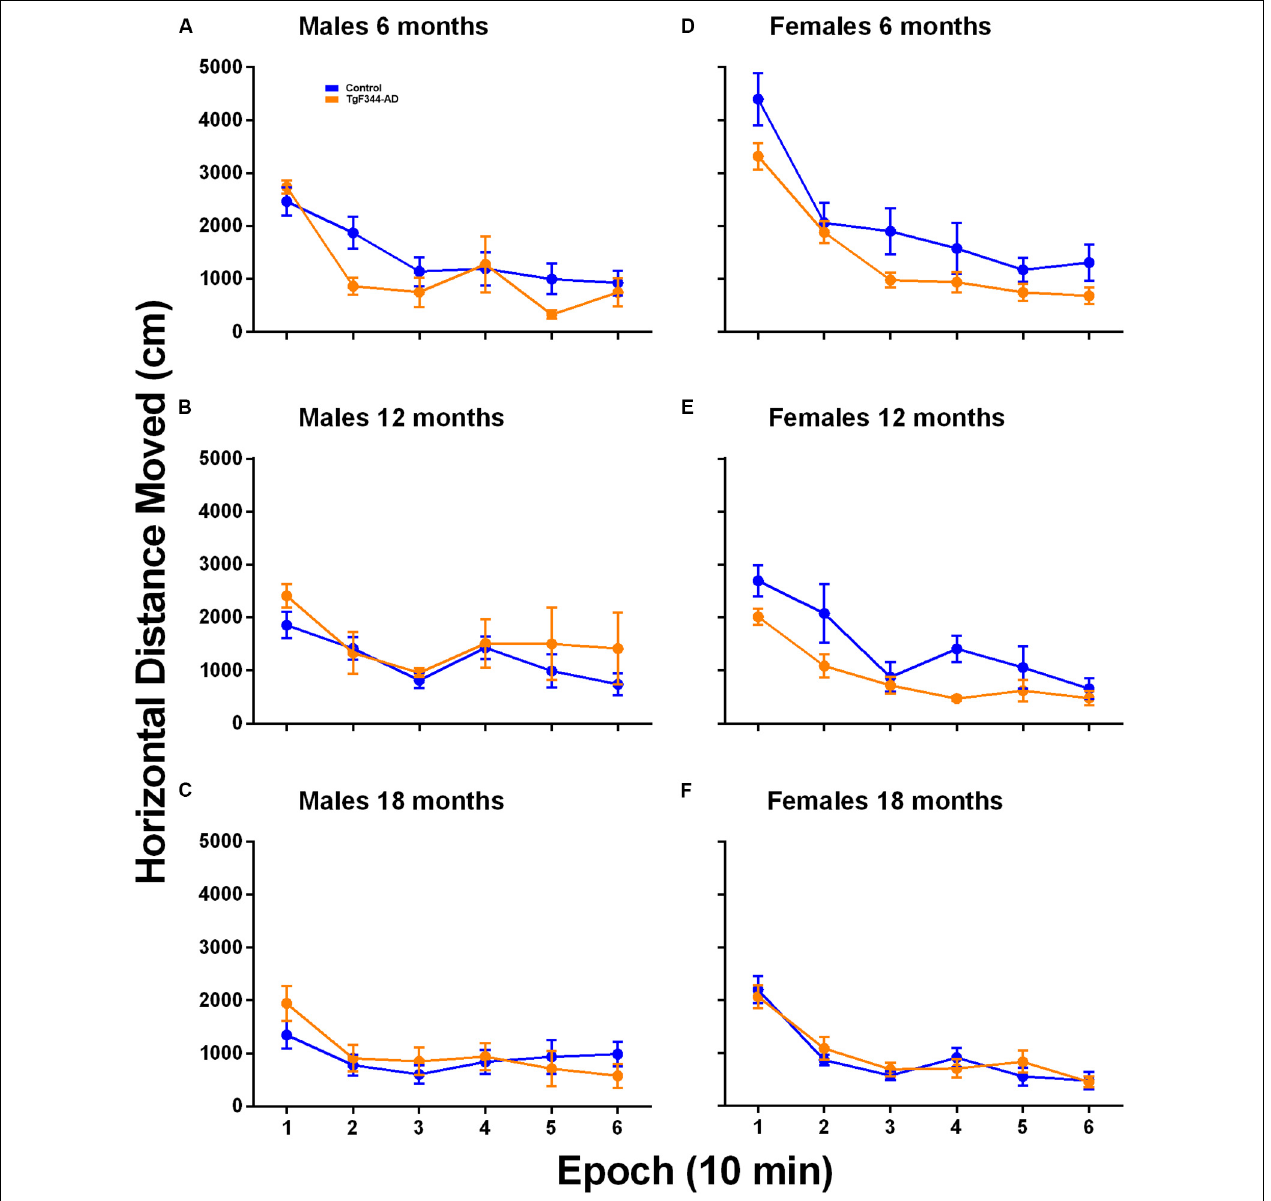
FIGURE 3 | Open field activity in (A–C) male and (D–F) female TgF344-AD and control rats at (A,D) 6 months, (B,E) 12 months, and (C,F) 18 months of age. Each point is the mean ± SEM in nine male controls, five male TgF344-AD, six female control and 15 female TgF344-AD rats. For males, only the main effect of epoch was statistically significant ( p < 0.001) indicating habituation over the 60 min testing period regardless of either age or genotype. For females, the age × epoch ( p < 0.001) interaction was statistically significant indicating that regardless of genotype habituation decreased with increasing age likely due to decreased responsivity to the environment in the 12- and 18-month old animals. Moreover, in females, the genotype × age ( p = 0.013) interaction was statistically significant, indicating that in the 6 and 12 month old groups, AD rats were hypoactive compared with controls; activity levels were similar in the two genotypes at 18